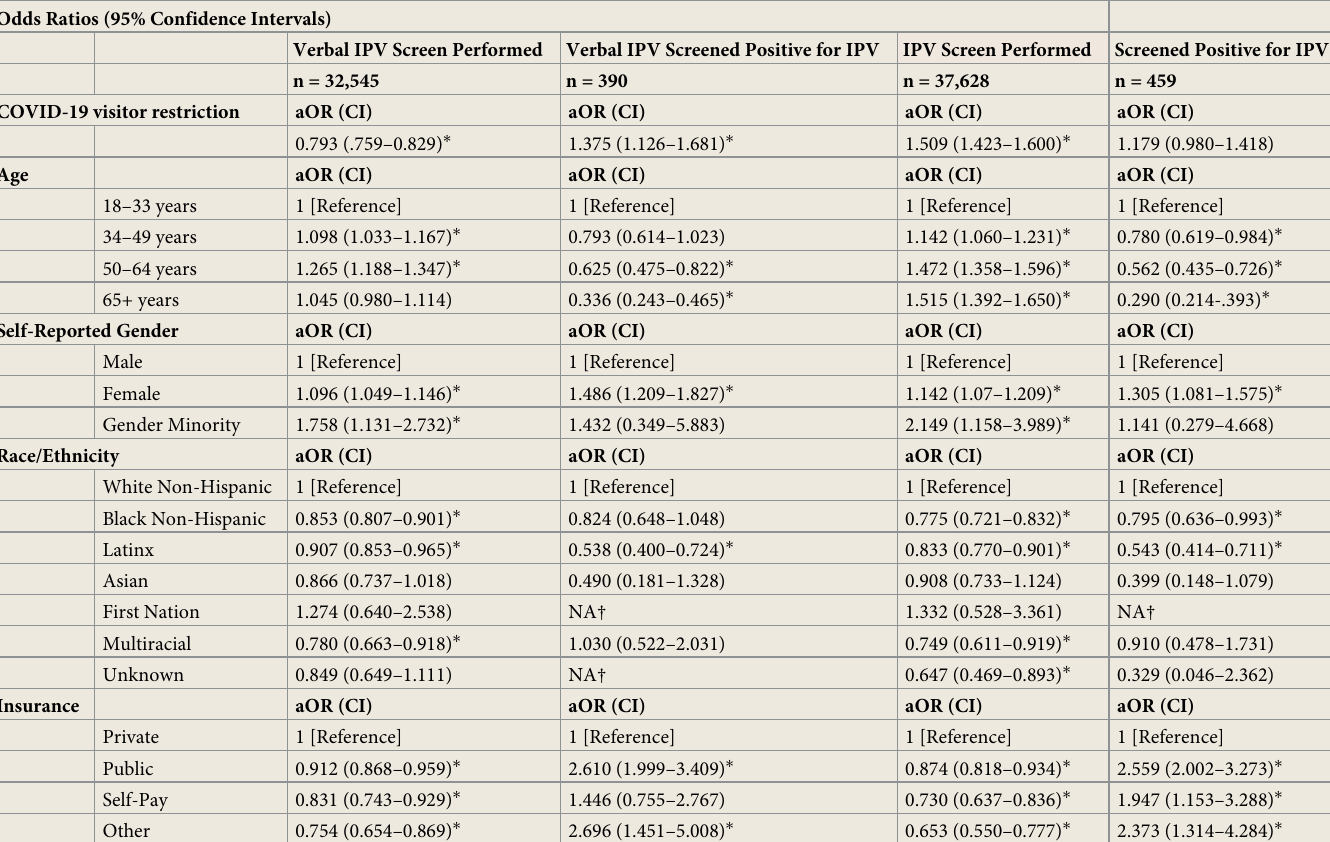
Table 3. Fully adjusted binary logistic regression analysis of (1) Verbal IPV screening pre- and post-COVID-19, (2) Verbal IPV screening positive vs negative, (3) IPV screening pre- and post-COVID-19, (4) IPV screening positive vs. negative. Odds Ratios (95% Confidence